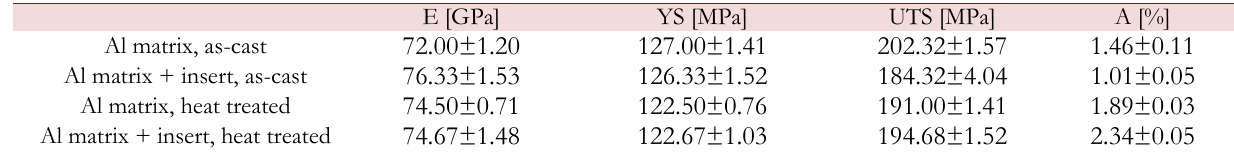
Table 2: Comparison between the mechanical properties of the compound casting and the aluminum alloy.